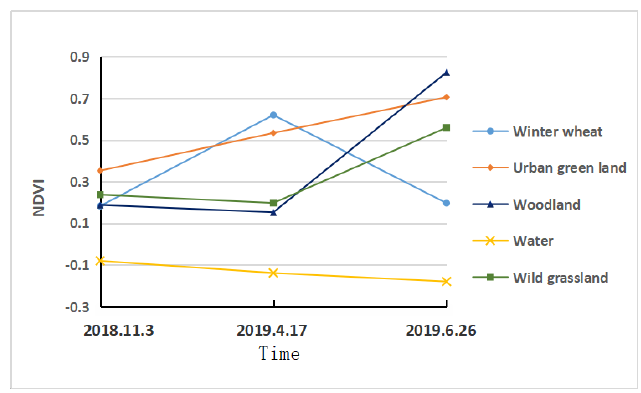
Figure 2. Changes of NDVI of different vegetation types in the study area with time.